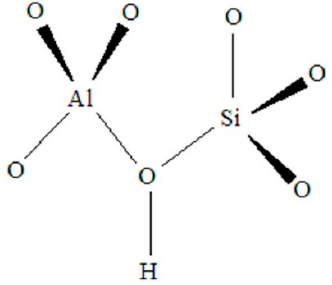
Figure 4. Tetrahedral arrangement of the Si–O and Al–O bonds forming a unit block of zeolite. Reproduced from Reference [63] under CC BY 4.0.